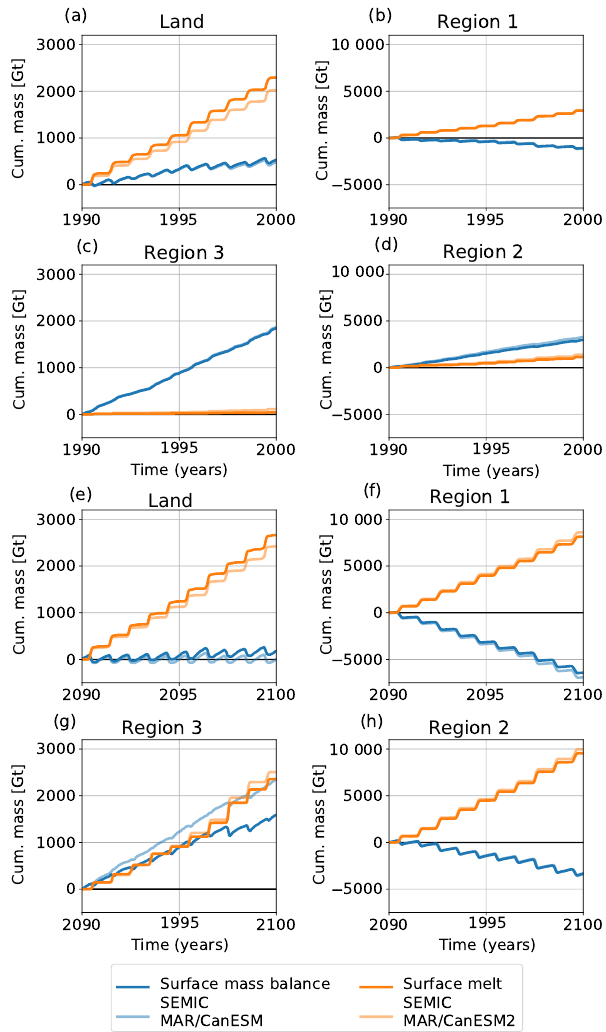
Figure 7. Cumulative sum of surface melt and surface mass bal- ance over the four different regions as defined in Fig. 2 and both calibration periods, 1990–1999 (a–d) and 2090–2099 (e–h) . Note the different y scale for the land/region 3 (a) , (c) , (e) , and (g) and for region 1/region 2 (b) , (d) , (f) , (h) .